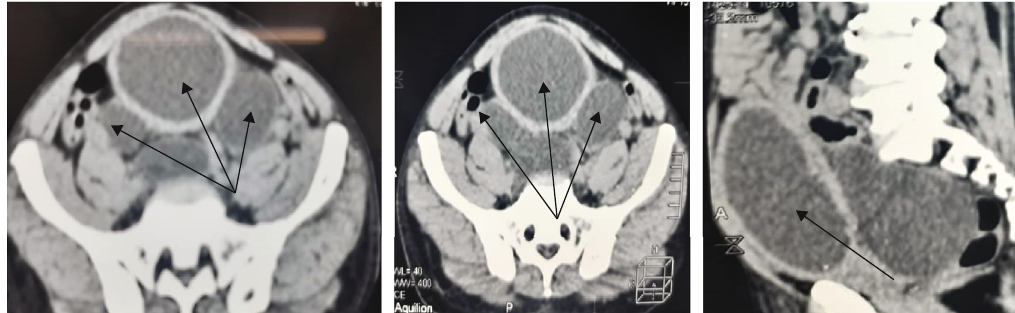
Figure 1: Computed tomographic (CT) scan of the abdomen and pelvis showing multiple bladder diverticula (black arrow).